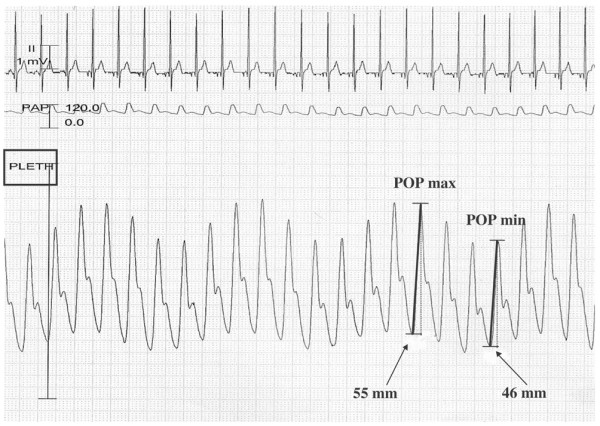
Pulse oximetry plethysmographic waveform analysis. Shown is pulse oximetry plethysmographic (POP) waveform (PLETH) analysis in one illustrative patient. Beat-to-beat measurement of POP waveform amplitude allowed determination of maximal POP (POPmax) and minimal POP (POPmin) over a single respiratory cycle.